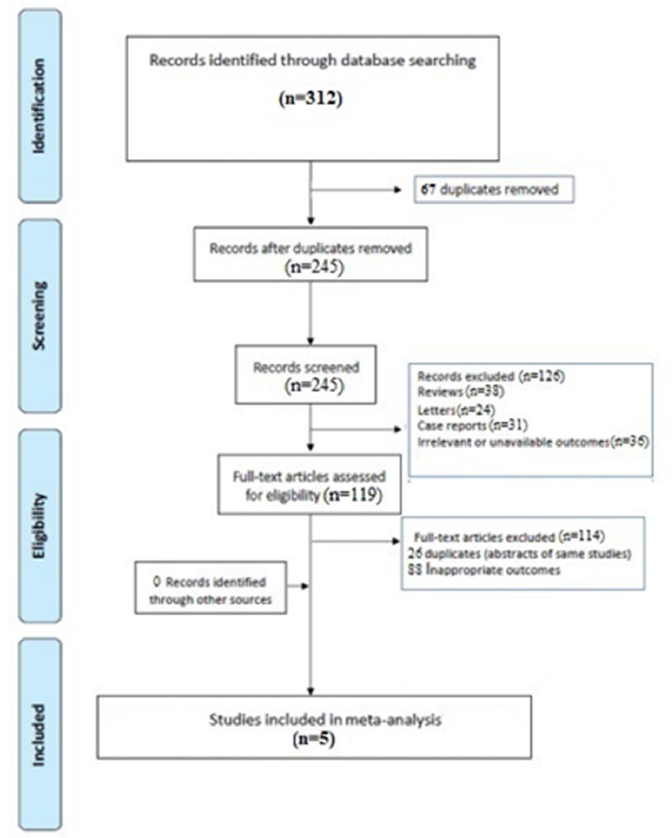
Figure 1. PRIMA flow chart .